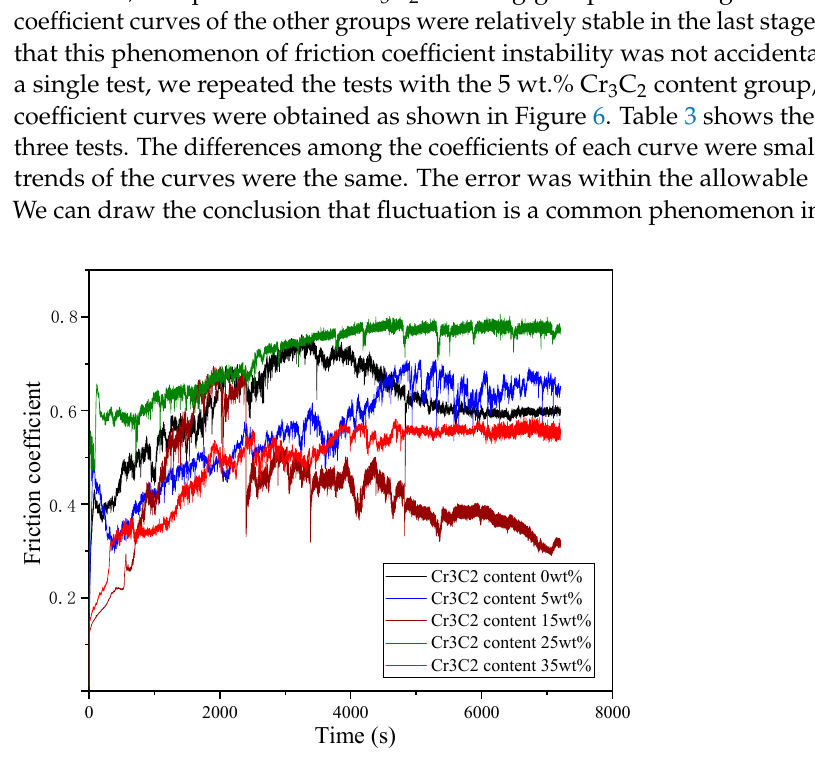
Figure 5. Friction coefficient curves of vermicular graphite cast iron and cladding layers with the same process and different Cr 3 C 2 content.